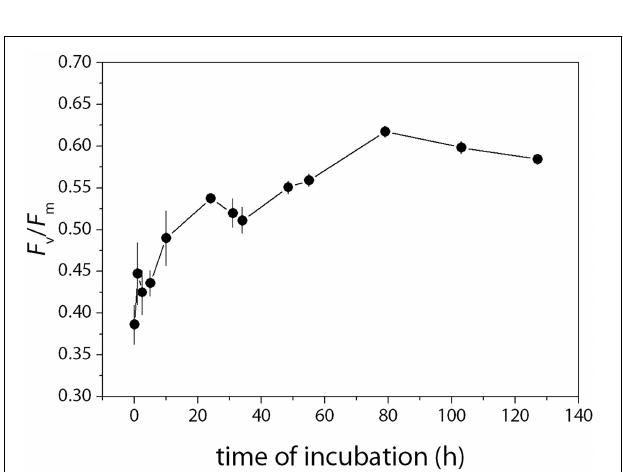
FIGURE 6 | Changes in the maximum photochemical efficiency of PSII ( F v / F m ) during the incubation. F v / F m was measured at each sampling time using a pulse amplitude modulated fluorometer (Water-PAM, Walz, Germany). The saturating pulse was provided by a red-LED with a peak illumination at 655 nm and set at 7,000 µ mol photons m − 2 s − 1 and lasted for 400 ms for all measurements (Yan et al., 2019). The maximum photochemical efficiency of PSII was calculated as F v / F m = ( F m – F o )/ F m . F o is the minimum fluorescence after the darkness of 30 min and F m is the maximum fluorescence under the saturation pulse. Mean values ( ± SD) are the average of four independent measurements.